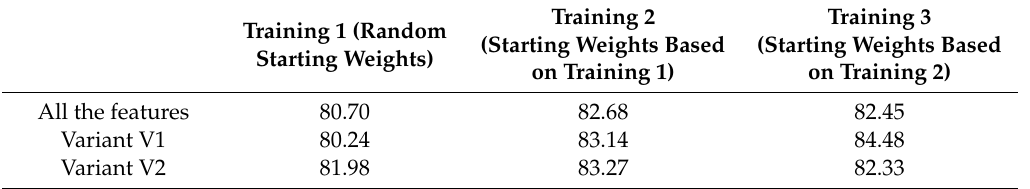
Table 14. Recognition rates [%] obtained using weight transfer in the Bidirectional long